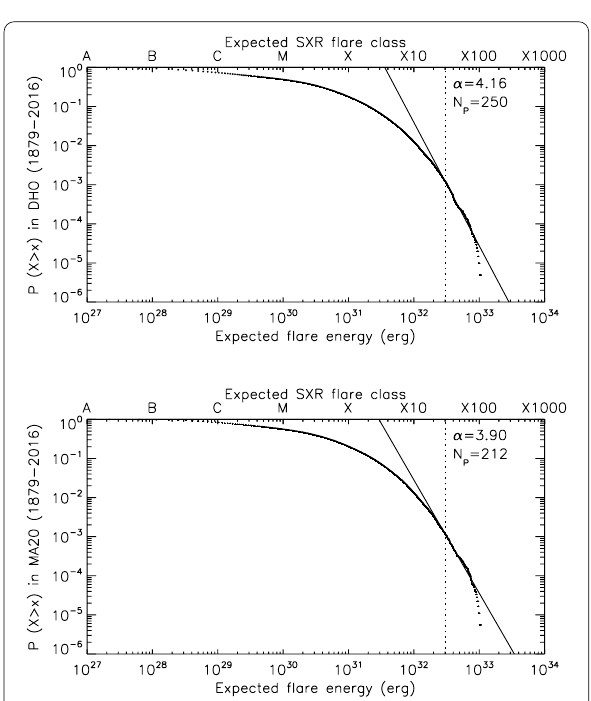
Fig. 6 Complementary cumulative distribution of occurrence number as a function of flare energy or SXR flare class calculated from sunspot area in the DHO (upper panel) and MA20 (lower panel)